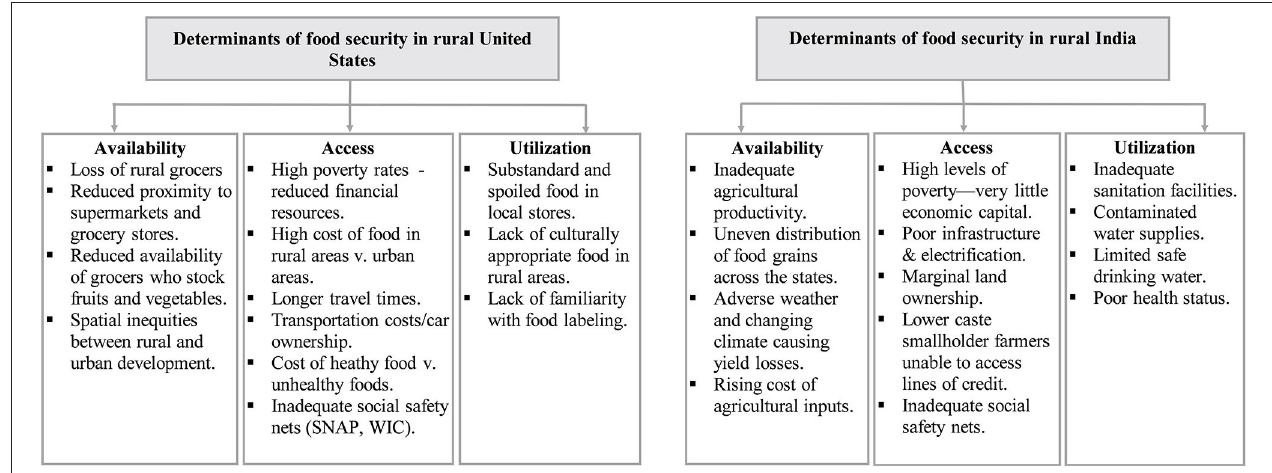
FIGURE 3 | Comparative analysis of food security determinants between the rural United States and